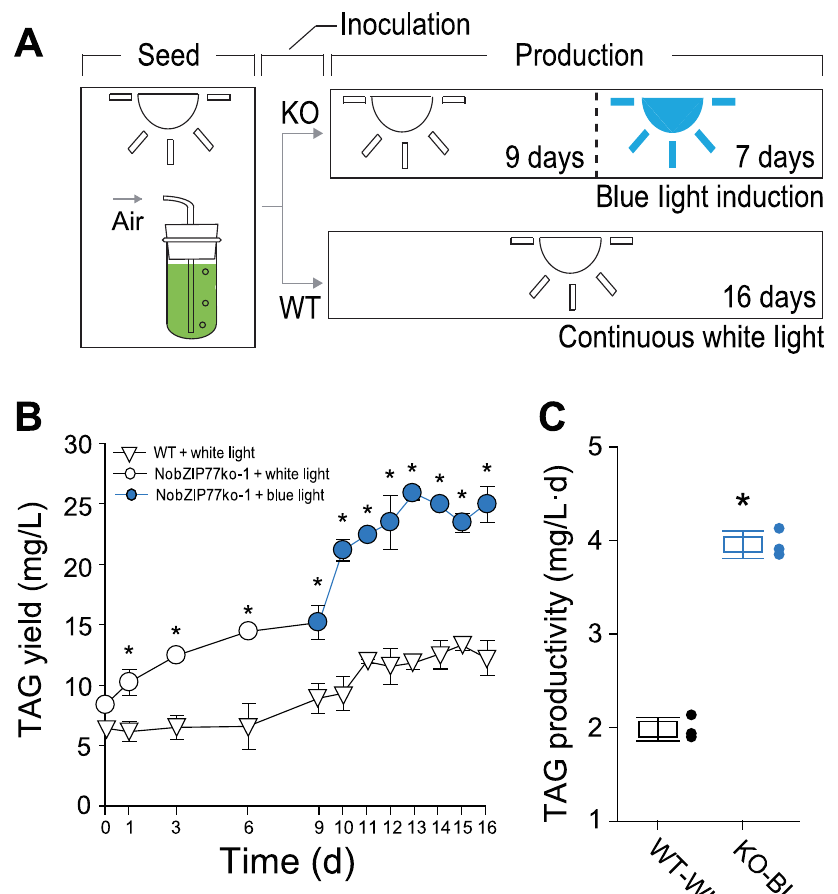
Fig. 6 The blue-light-induced oil-production strategy. This experiment was conducted to present the advantage of BL plus NobZIP77 -KO-approach, as compared to continuous WL plus WT (the conventional traditional way of microalgal cultivation). Data for BL induction of WT under both N + and N − are presented in both Fig. 5 and Supplementary Fig. 19. A Experimental design of BLIO: the NobZIP77ko-1 line of N. oceanica was cultured under WL for 9 days and then under BL for 7 days. WT grown under WL for 16 days (WT-WL) was used as the control. B , C Comparison of TAG yield (mg/L) ( B ) and average TAG productivity (mg/L·d) ( C ) between the two approaches. Data are represented as mean ± SD ( n = 3 biologically independent samples). *: signi fi cant change ( p ≤ 0.05) by one-sided Student ’ s t -test versus the control. Source data are provided as a Source data fi Data 2). Positive lines were then cultured for further veri fi cation of transcript change. For phenotyping, the transgenic lines (plus the controls, e.g., WT transformed with empty vector or EV) were grown to OD 750 of 4.5± 0.5 for fi ve days, and then the content and FA pro fi les of both TAG and total lipids were tracked at 0h, 24 h, 48h, 72 h, and 96 h under N − . Three series of experiments that involved light control were performed: (1) The fi rst series investigated the impact of NobZIP77-mediated regulation of TAG synthesis by blue light (BL) in vivo. N. oceanica cells (WT and knockout mutant NobZIP77ko-1) were cultured in modi fi ed f/2 medium under continuous whitelight tilllog phase.Cells were kept in darkness for 36h, and then harvested by centrifugation (3500× g , 5min) and resuspended in fresh modi fi ed f/2 medium (N + /N − ). The resuspended cells were transferred into bio-reaction tubes and then cultured under darkness, green light (550nm, 50±5µmolphotonsm − 2 s − 1 ) or BL (445nm, 50±5µmolphotonsm − 2 s − 1 ), by exposing the samples to a customized LED illumination system that allows modulation of the spectral composition and intensity of lights. Each group included three replicates. Cell aliquots were taken at 24h from each of the columns for Raman spectra measurement and TAG content analysis. (2) The second experimental series probed the potential of exploiting the NobZIP77-mediated signaling pathway in elevating microalgal TAG productivity. N. oceanica cells were cultured in modi fi ed f/2 medium under continuous white light (WL) till log phase. Cells were harvested by centrifugation (3500× g , 5 min) and resuspended in the N + or N − medium (modi fi ed f/2 medium without NaNO 3 ). Then the resuspended cells (OD 750 = 4) were cultured under WL (50 ±5 µmolphotons m − 2 s − 1 ) or BL (445nm, 50± 5µmol photons m − 2 s − 1 ), by exposing samples (in triplicates) to a customized LED illumination system. Cell aliquots were taken from each column (0 h, 24 h, 72h, 144h, 216h, and 264 h for N + ; 0h, 6h, 12 h, 24h, 48 h, 72h, 96h, 120 h, 144 h, 168h, 216 h, and 264h for N − ) for growth measurement, Raman spectra acquisition, and TAG content analysis.